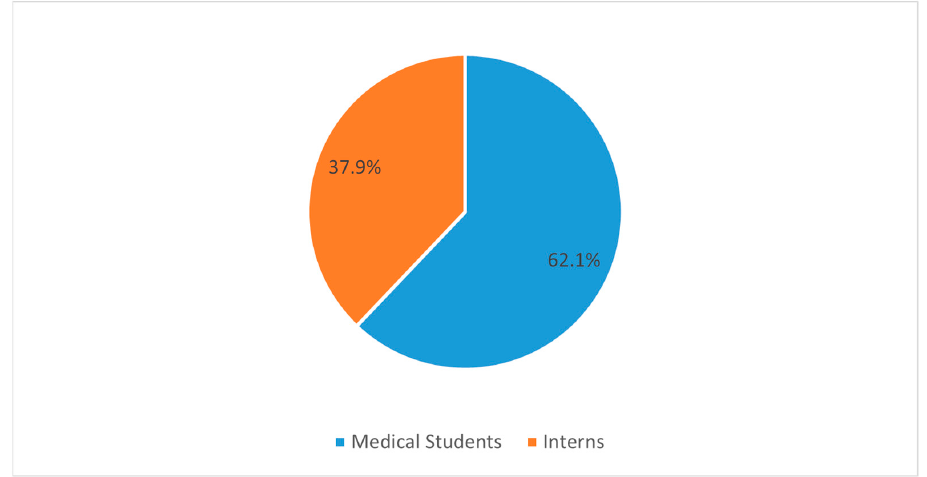
Figure 3. Pie chart demonstrates the distribution the respondents based on their seniority being medical students versus interns.